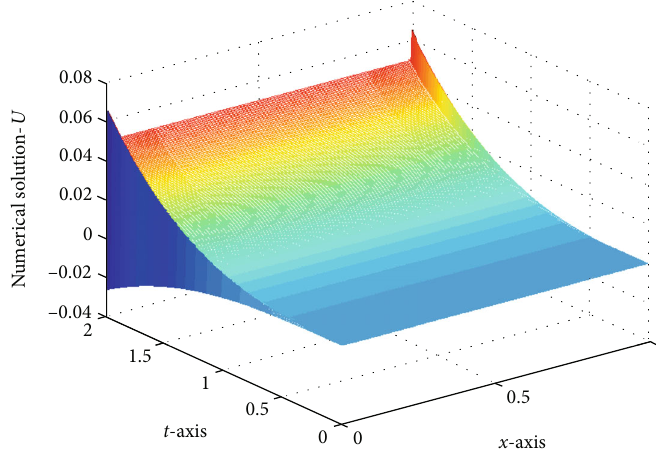
Figure 1: Numerical simulation at N = 2 7 , Δ t = 0 : 1/2 4 , ε = 2 − 12 , λ = − 0 : 55